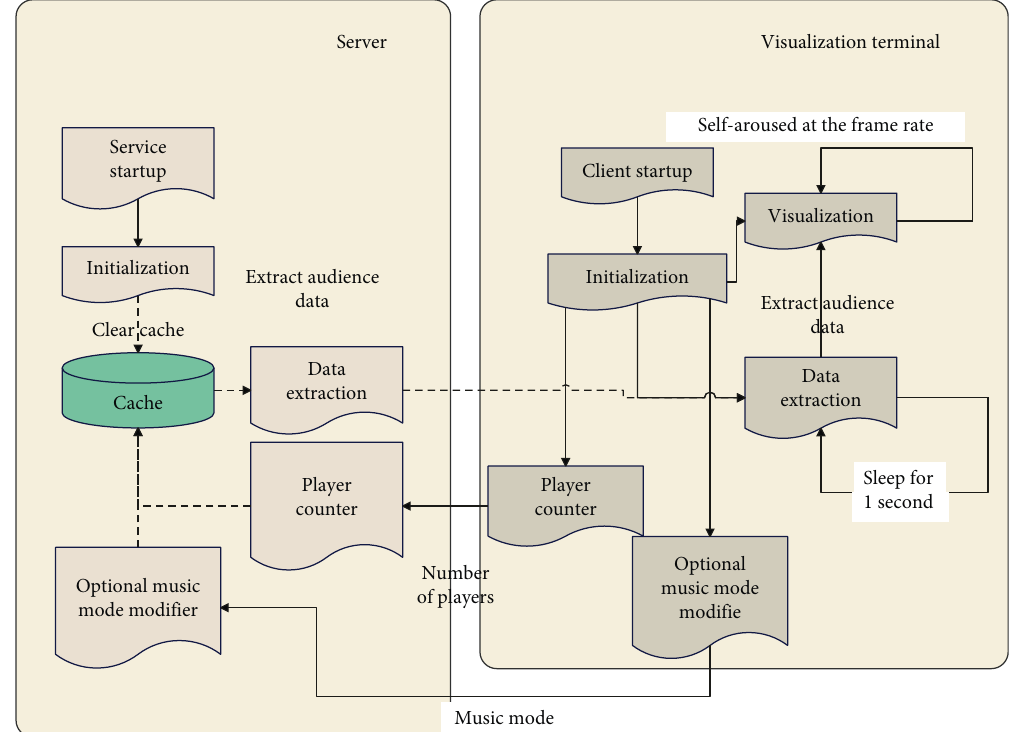
Figure 10: Functional modules of the symphony smart creation system.